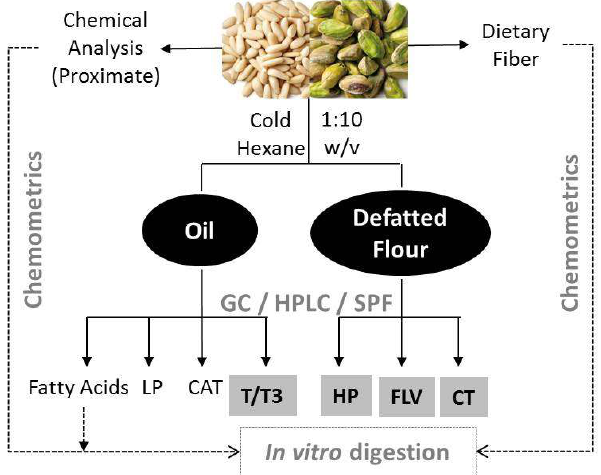
Figure 1. Experimental design. See text for experiment description. Methods: Gas chromatography (GC), high-performance liquid chromatography (HPLC) or spectrophotometry (SPF); Analytical assays: Carotenoids (CAT), lipophilic (LP) and hydrophilic (HP) phenolic compounds, tocols (T/T3), flavonoids (FLV), and condensed tannins (CT).